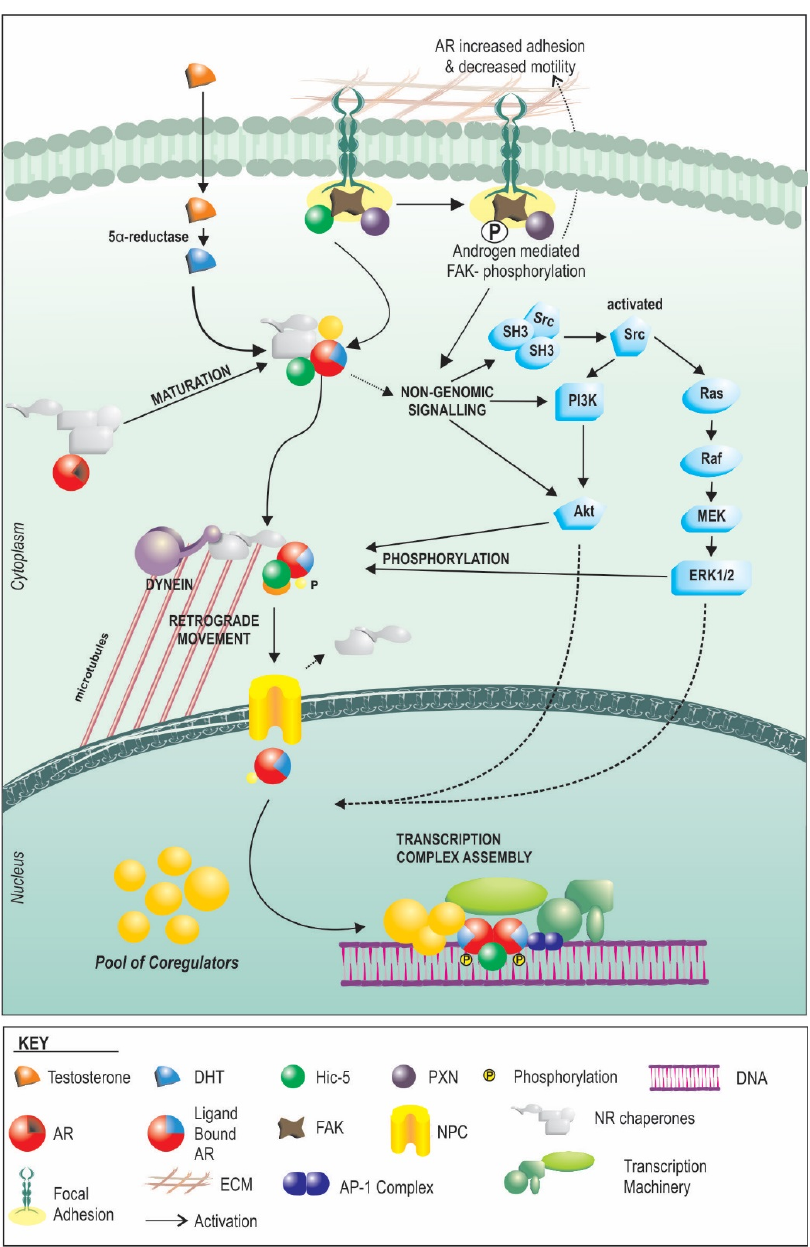
Figure 1. Schematic of androgen receptor (AR) signalling in fibroblasts/myofibroblasts.